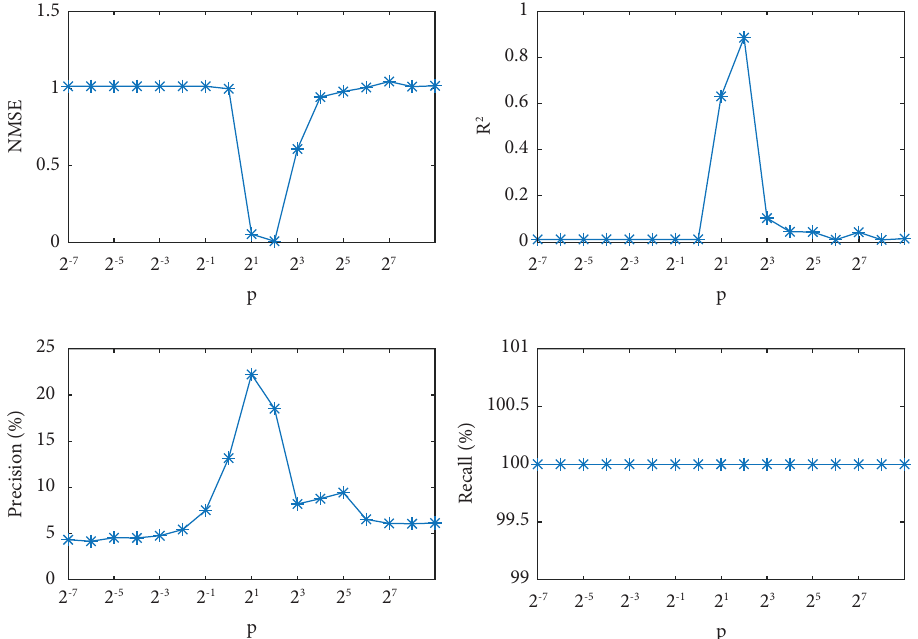
Figure 3: Te infuence of p on NMSE, R 2 , precision, and recall for the Type C dataset. Parameter C is fxed as the optimal value.